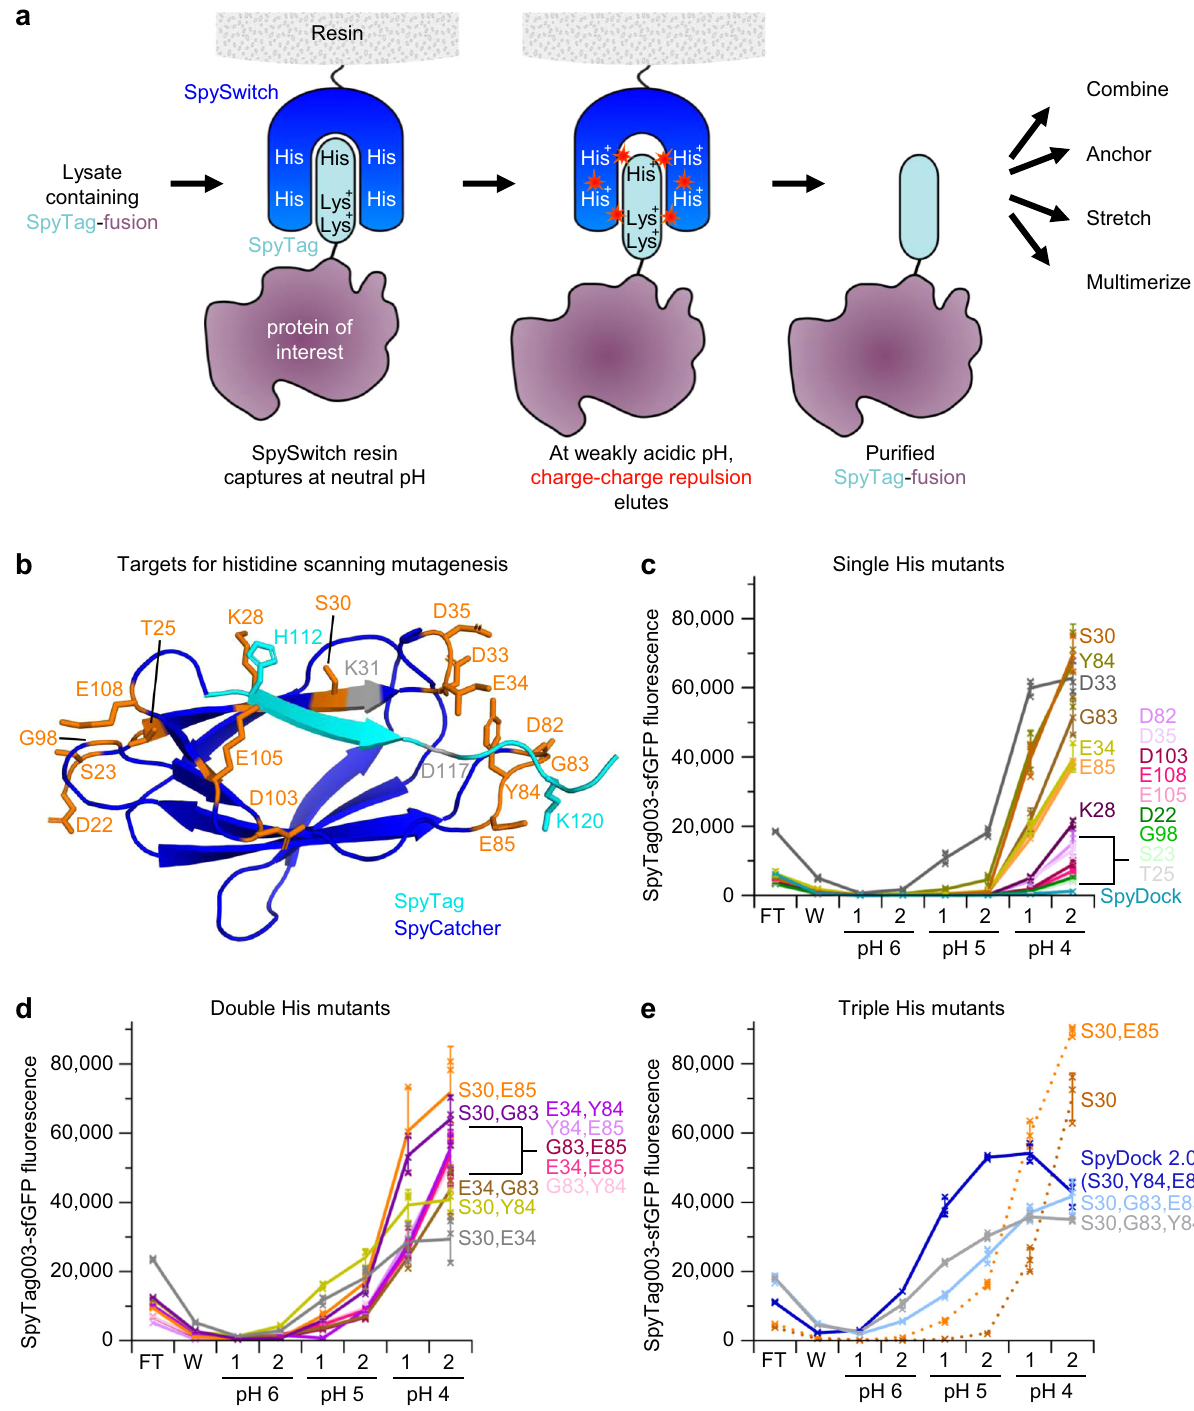
Fig. 1 Rational engineering of SpySwitch. a Overview of SpySwitch concept. SpyTag fused to a protein of interest interacts with SpySwitch at neutral pH and is eluted at weakly acidic pH through charge-charge repulsion (represented by red stars). b Residues at the interface of the SpyTag:SpyCatcher interaction chosen for histidine mutagenesis are marked in orange. SpyCatcher is in dark blue, based on the CnaB2 domain of PDB ID: 2X5P. SpyTag is in cyan, based on PDB ID: 4MLI. Reactive residues K31 and D117 that form an isopeptide bond in SpyTag:SpyCatcher are colored gray. H112 and K120 side- chains on SpyTag (K123 is not resolved in PDB ID: 4MLI) are marked as potential sites of electrostatic repulsion. Certain residues that were selected for mutation in the SpyCatcher003 parent are different to the SpyCatcher grandparent. c Single histidine variants of non-reactive SpyCatcher003 were assayed for SpyTag003-sfGFP binding and stepwise pH elution from pH 6.0 to pH 4.0. Each fraction was neutralized before fl uorescence detection of SpyTag003-sfGFP. FT, fl ow-through; W, wash (pH 8.0). d Double histidine variants of non-reactive SpyCatcher003 were assayed as in ( c ). e Triple histidine mutants were assayed as in ( c ), compared to the best single and double mutant. Individual data points are shown as crosses. The connecting line goes through the mean, with the error bars ± 1 s.d. ( n = 3). Fluorescence is given in arbitrary units. Source data are provided as a Source data fi